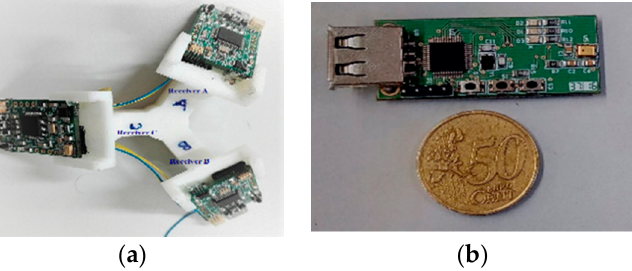
Figure 3. General aspect of the 3D receiver assembly: ( a ) the receiver assembly based on three single receivers; ( b ) a view of a single receiver.